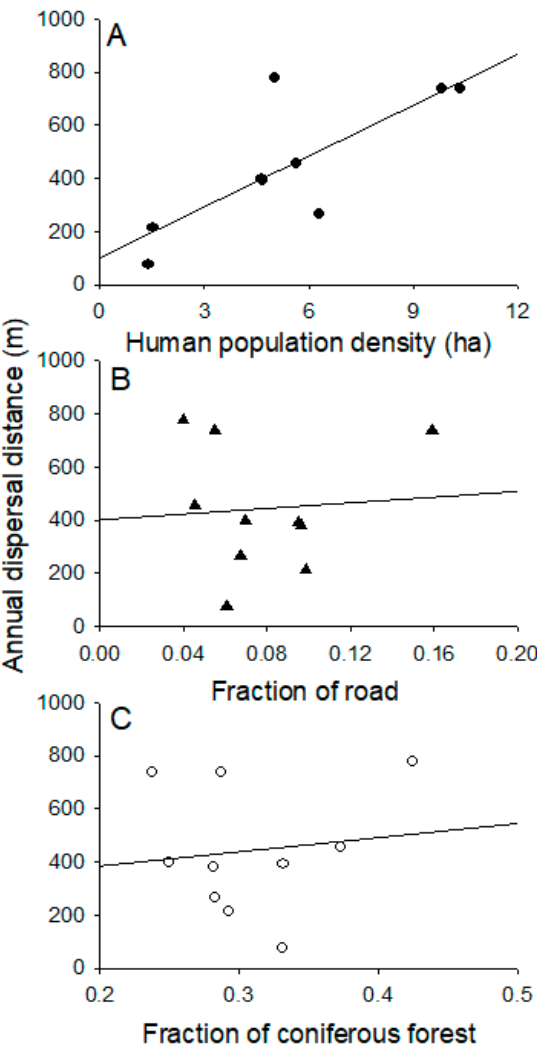
Figure 5. Relationships between annual dispersal distance and ( A ) human population density; ( B ) fraction of coniferous forest to total area and ( C ) fraction of road density to total land cover area.